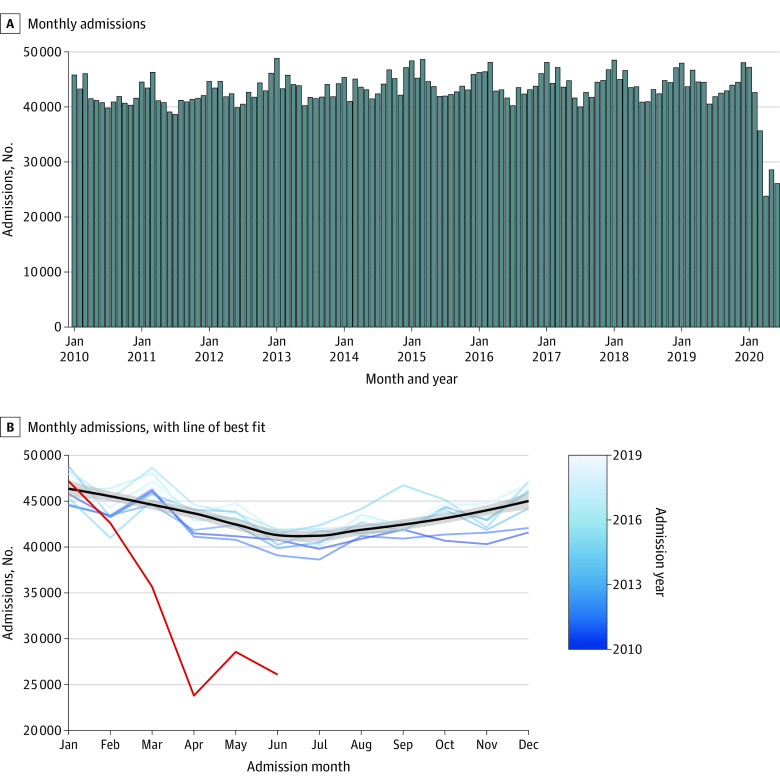
Monthly Admissions in Pediatric Health Information SystemsA, Number of monthly admissions in Pediatric Health Information Systems between January 2010 and June 2020, represented as a bar chart. B, Number of monthly admissions between January 2010 and June 2020 represented as a line chart. Each blue line represents an admission year between 2010 and 2019, with progressively lighter shades of blue representing later years. The black line represents the line of best fit for the data using locally estimated scatterplot smoothing. The gray bar represents the 95% CI of the regression line. The red line shows the number of monthly admissions from January through June 2020.